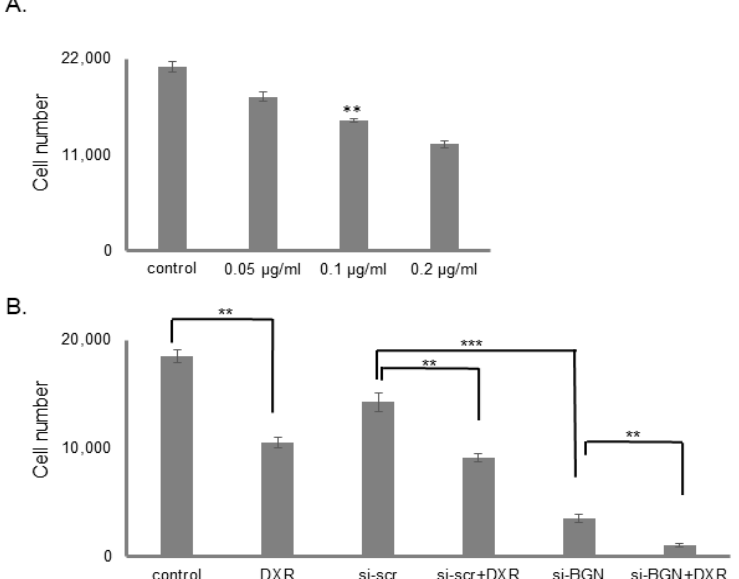
Figure 11. Effect of biglycan and doxorubicin on MG63 cells proliferation. MG63 cells were harvested and seeded (1,500 cells/well) on 96-well plates and transfection with siRNAs (short interfering RNAs) was performed, when needed. ( A ) Control cells were treated with completed culture medium and samples were treated with different doxorubicin concentrations for 48 h. ( B ) Cells, in each well, were incubated in serum-free medium and transfected with either siRNAs against biglycan (siBGN) or scrambled siRNAs (siScr), used as negative control. After 24 h, the medium was replaced with 10% FBS DMEM and cells were incubated with 0.1 μ g/mL doxorubicin for 48 h. Cells, in each well, were counted after an incubation period, using fluorometric CyQUANT assay kit. Results represent the average of three separate experiments. Means ± S.E.M were plotted; statistical significance: ** p ≤ 0.01, *** p ≤ 0.001 compared with the respective control samples.